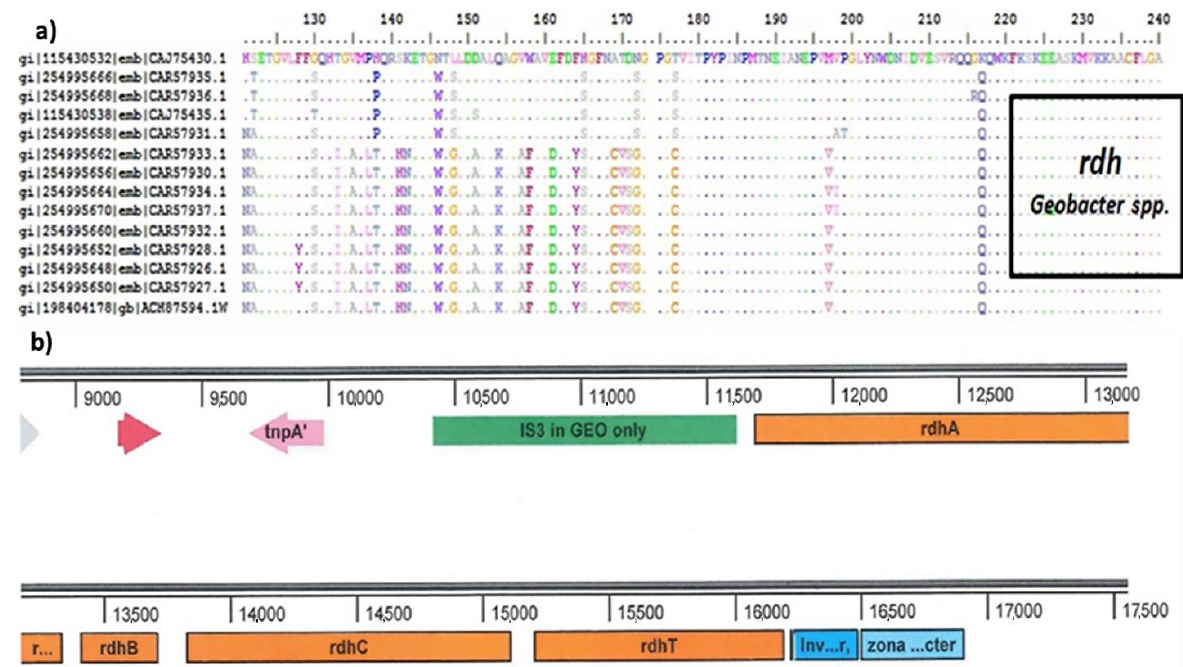
Figure 5. ( a ) Sequence of the area surrounding the rdh gene in an enrichment culture of Geobacter spp. and ( b ) characterization